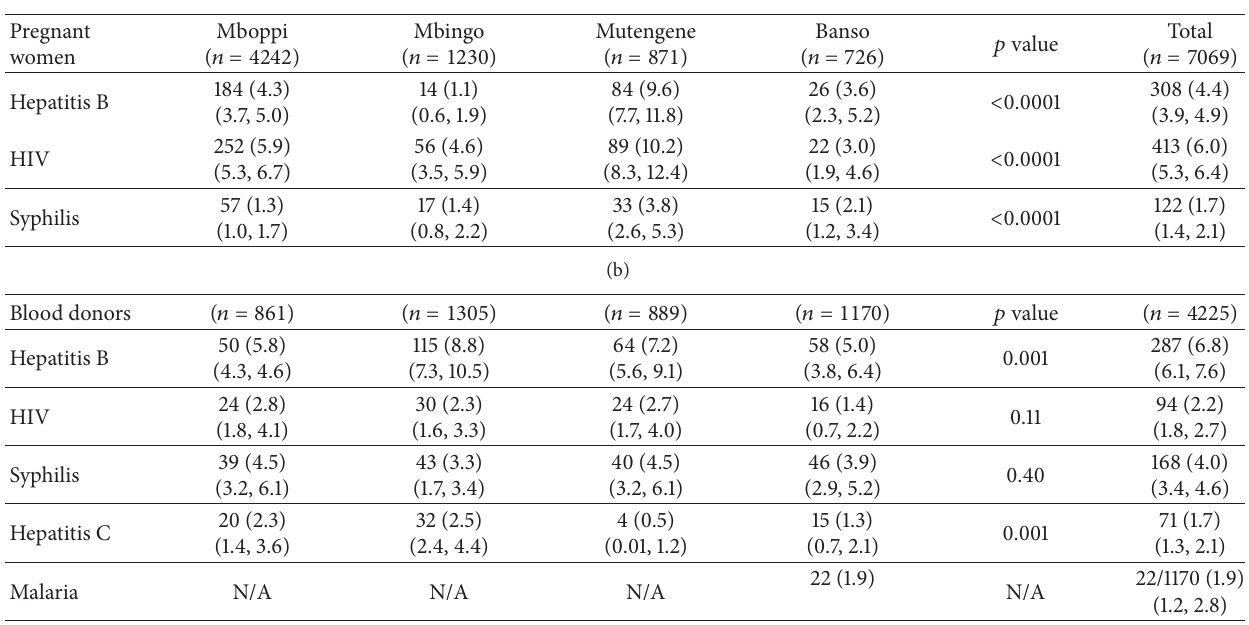
Table 3: Predictors of hepatitis B, HIV, and syphilis infection in pregnant women.